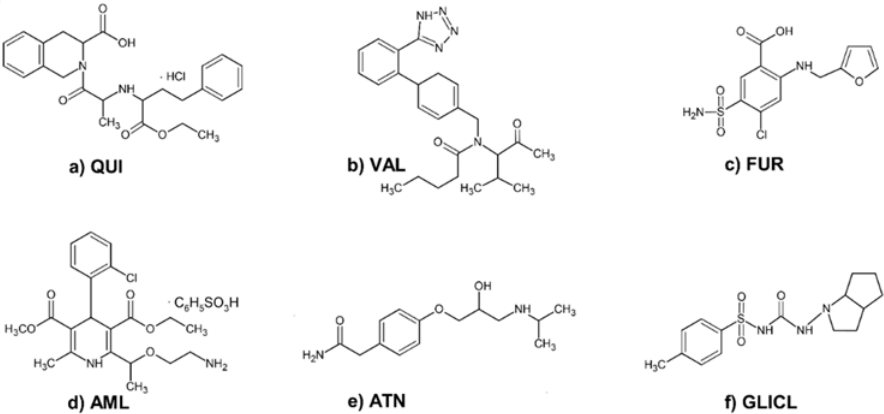
Figure 1. Chemical structures of: ( a ) quinapril hydrochloride (QUI), ( b ) valsartan (VAL), ( c ) furosemide (FUR), ( d ) amlodipine besylate (AML), ( e ) atenolol (ATN), and ( f ) gliclazide (GLICL).